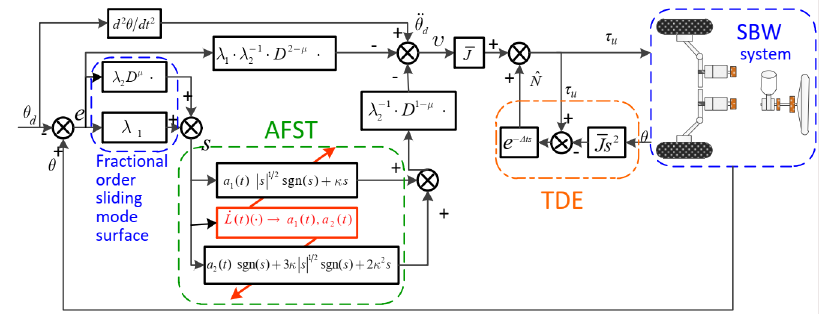
Figure 2. Block diagram of TDE-based AFST-FOSMC control